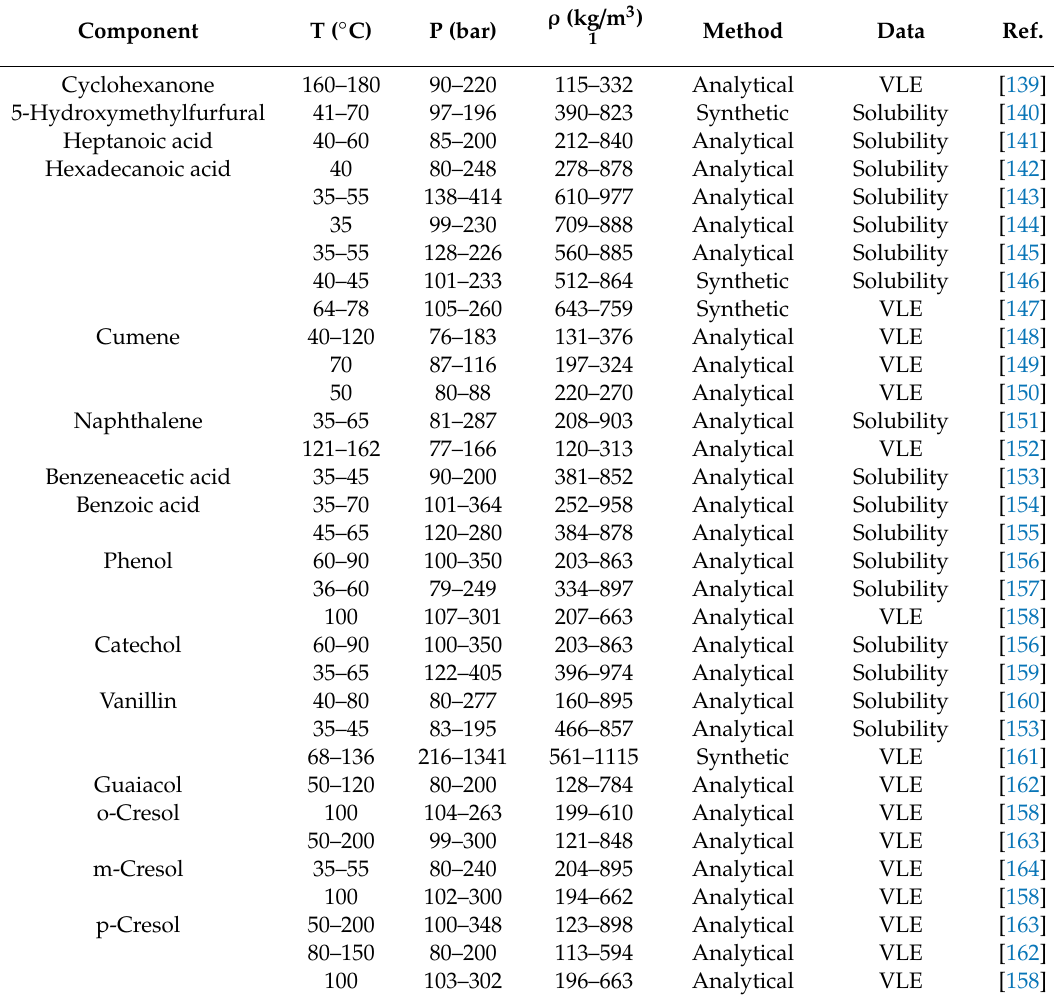
Table 9. Chemical components studied and experimental conditions of measured phase equilibrium data with sCO 2 in the literature. Temperature range (T), pressure range (P), sCO 2 density range ( ρ ), type of measurement (method), and type of data (data) are